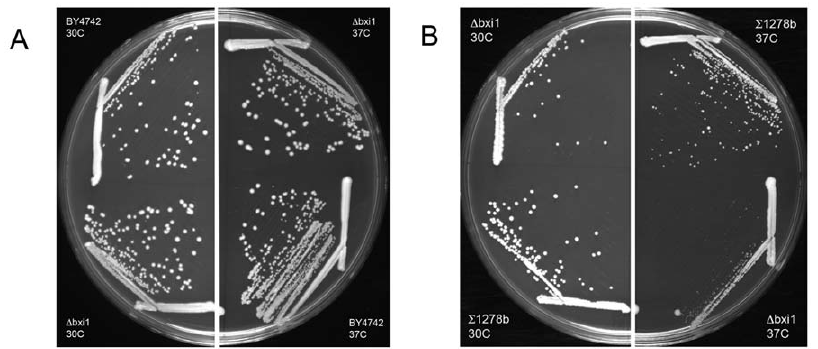
Figure 1. Wildtype and mutant D bxi1 cells have indistinguishable growth kinetics at 30 6 C. Wildtype and D bxi1 cells from the (A) BY4742 and (B) S 1278b strain backgrounds were streaked on rich YPD plates and cultured at 30 u C and at 37 u C for two days.